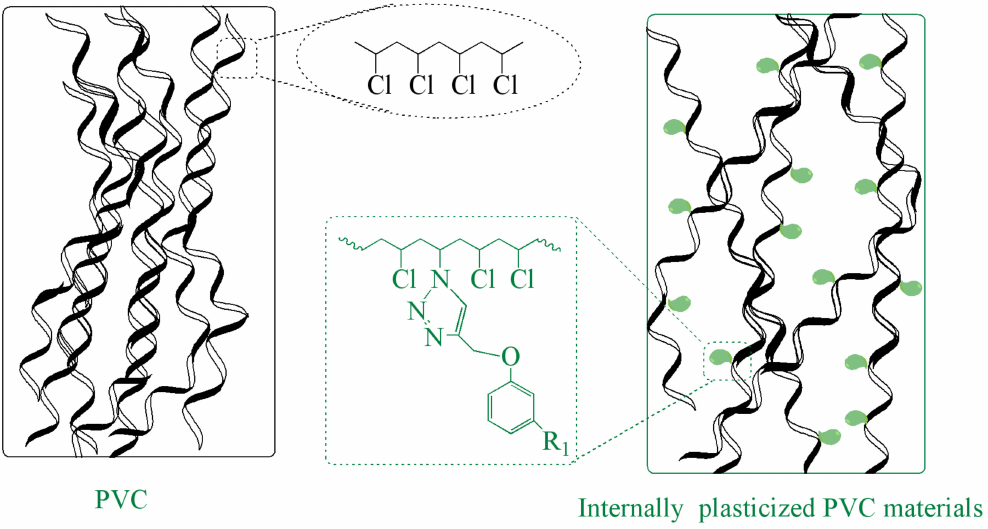
Figure 7. Structure of PVC and internally plasticized PVC materials under lubrication